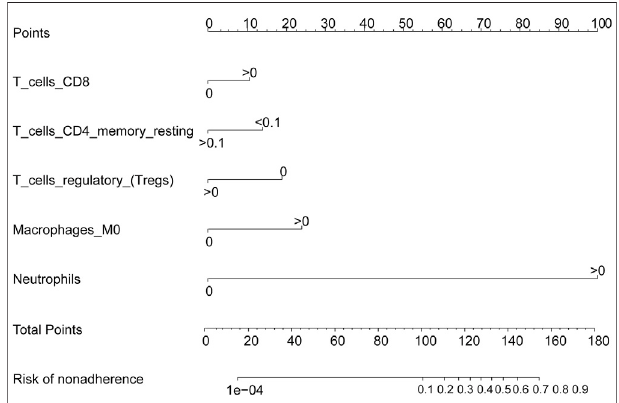
FIGURE 7 | Immune cell prediction model nomogram. The nomogram was constructed using the immune cell prediction